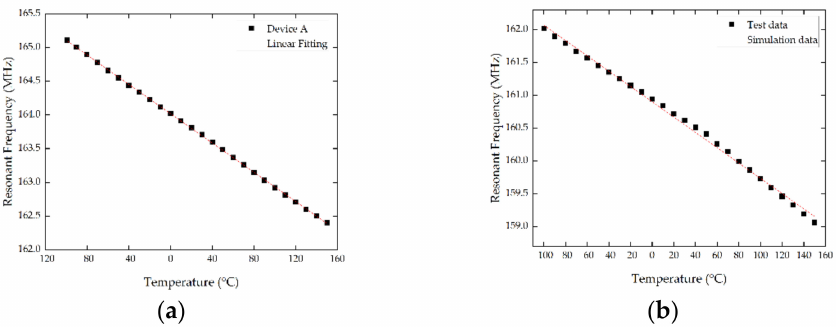
Figure 13. The frequency responsiveness of the SAW sensors during the experiment. ( a ) The frequency responsiveness of device A, and ( b ) the frequency responsiveness of device